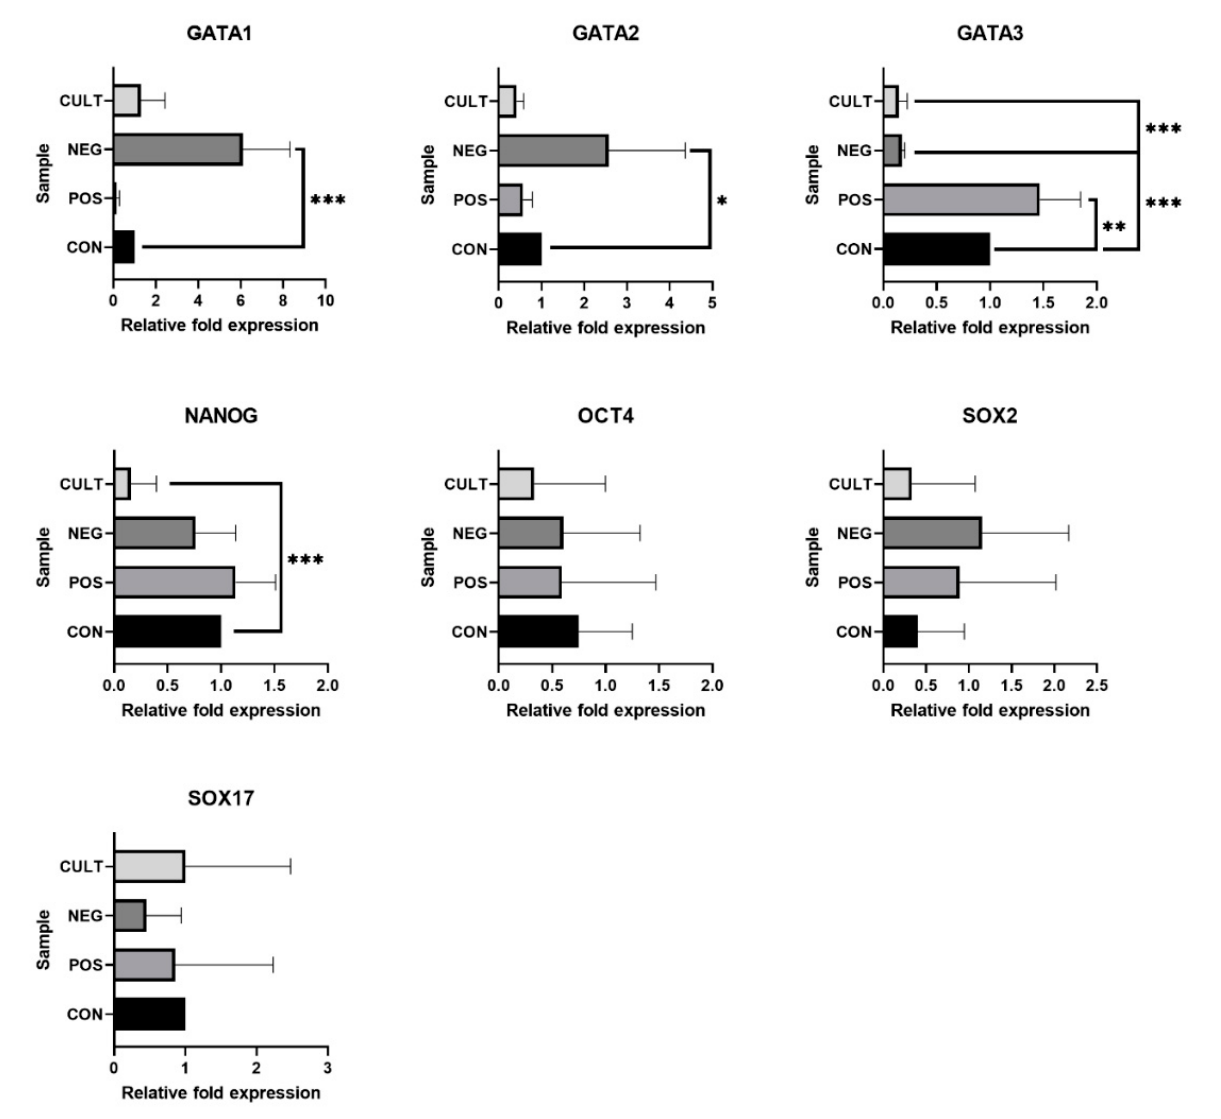
Figure 7. Relative expression of transcription factors analyzed in the control (unsorted) samples, sorted fractions and cultured cells. CON—control sample, NEG—negative fraction, POS—positive fraction, CULT—cultured cells. The data from five experiments are expressed as the mean ± SD; *—difference is statistically significant at p < 0.05; **—difference is statistically significant at p < 0.01; ***—difference is statistically significant at p < 0.001.